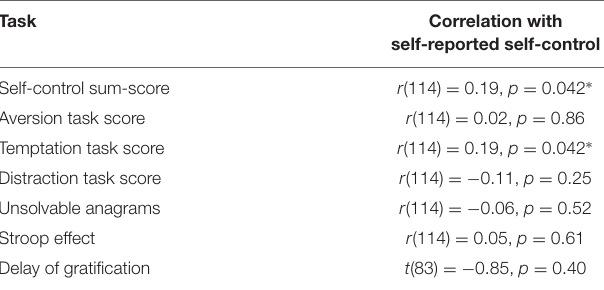
TABLE 4 | Correlation of self-control tasks with self-reported self-control. Task Correlation with self-reported